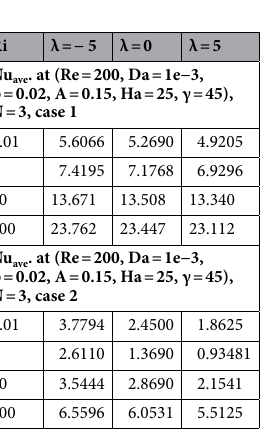
Table 13. Comparsion of average Nu for Case 1 and Case 2 at different Ri and λ.